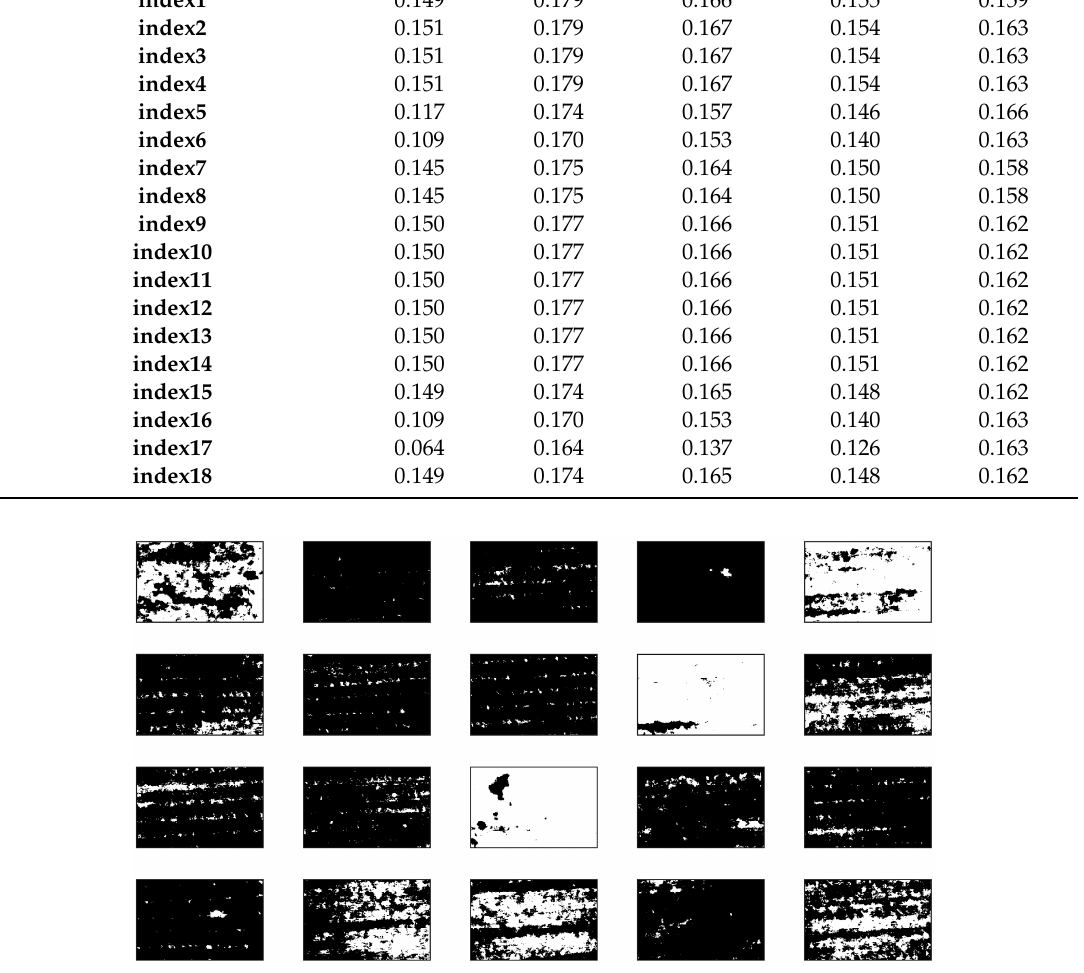
Figure A1. Crop binary map at flight altitude at 50 m using EXR-EXG method.